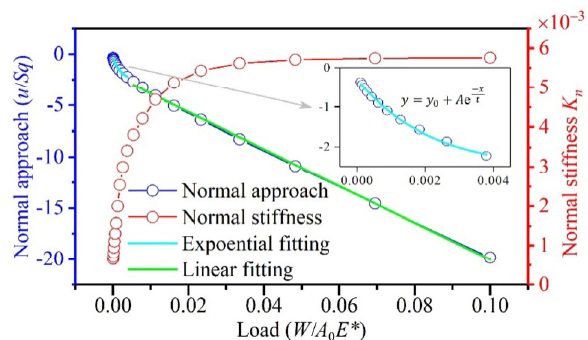
Fig. 7 Normal approach as a function of the applied load.